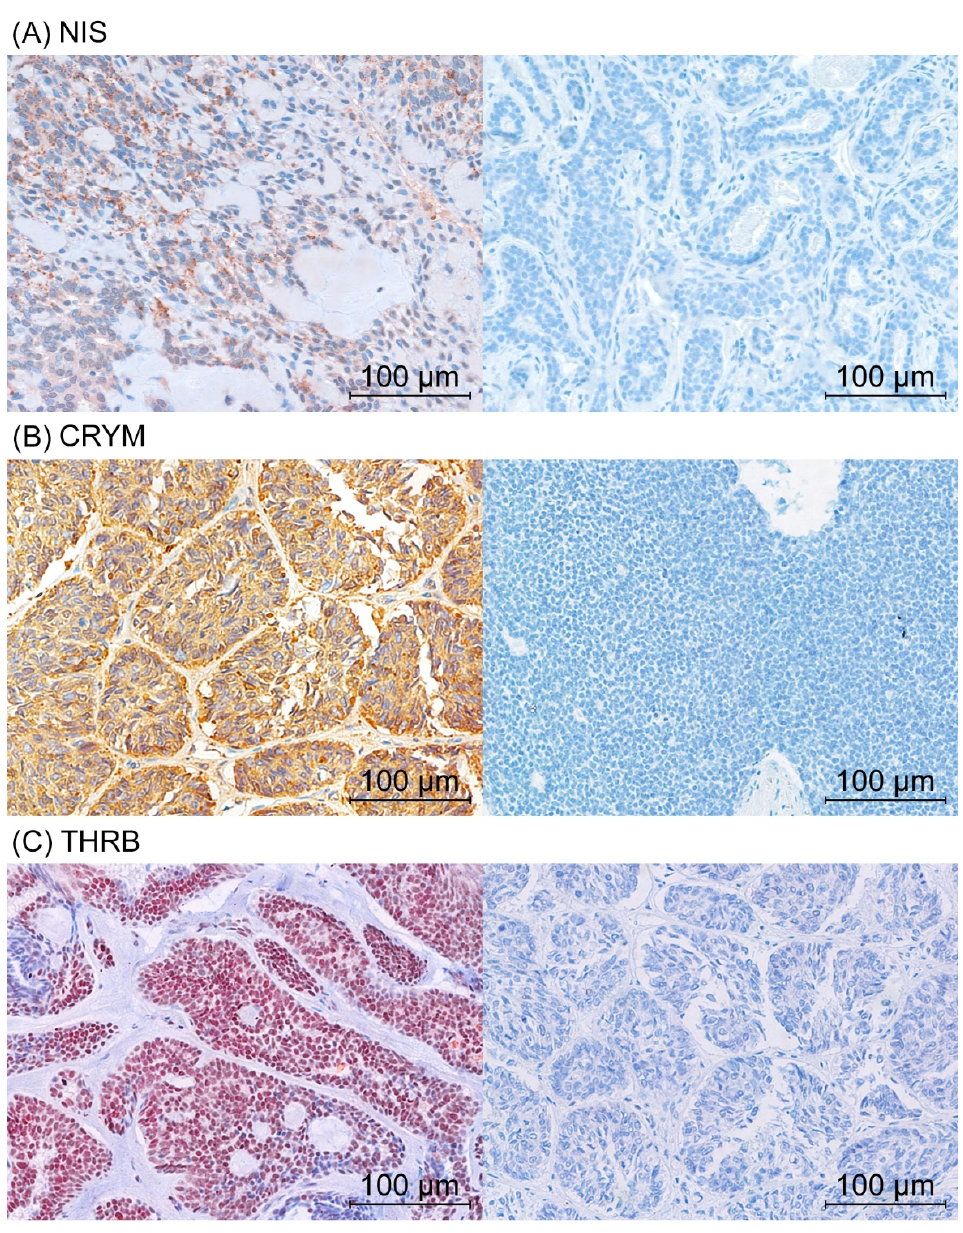
Figure 1. Immunohistochemical staining of NIS, CRYM, and THRB. Positive ( left ) and negative ( right ) immunohistochemical staining of NIS ( A ), CRYM ( B ), and THRB ( C ).